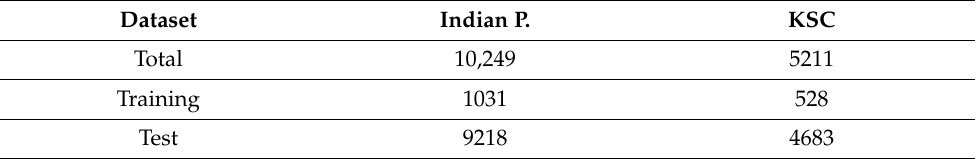
Table 1. Train/test sample numbers of the HSI datasets